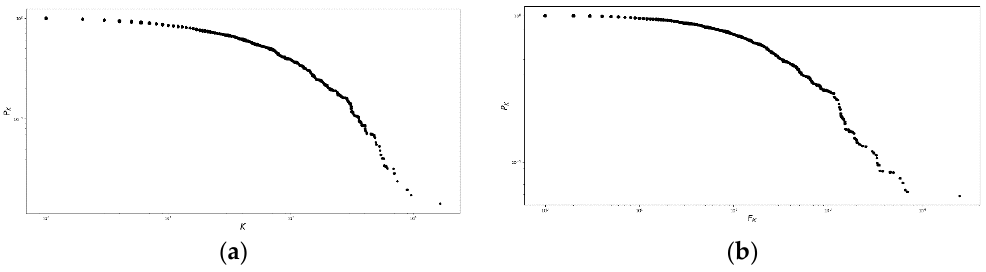
Figure 9. Clique with the highest overlap in morbidity and mortality networks. Mortality Network of Diseases for the victims of the armed conflict in Colombia, resident in the Risaralda province, from 2011 to 2016. Source: authors’ own calculations. Note that the ICD-X codes correspond to: E119: type 2 diabetes mellitus without complications, I119: hypertensive heart disease without heart failure, and E107: diabetes mellitus insulin dependent, with multiple complications.